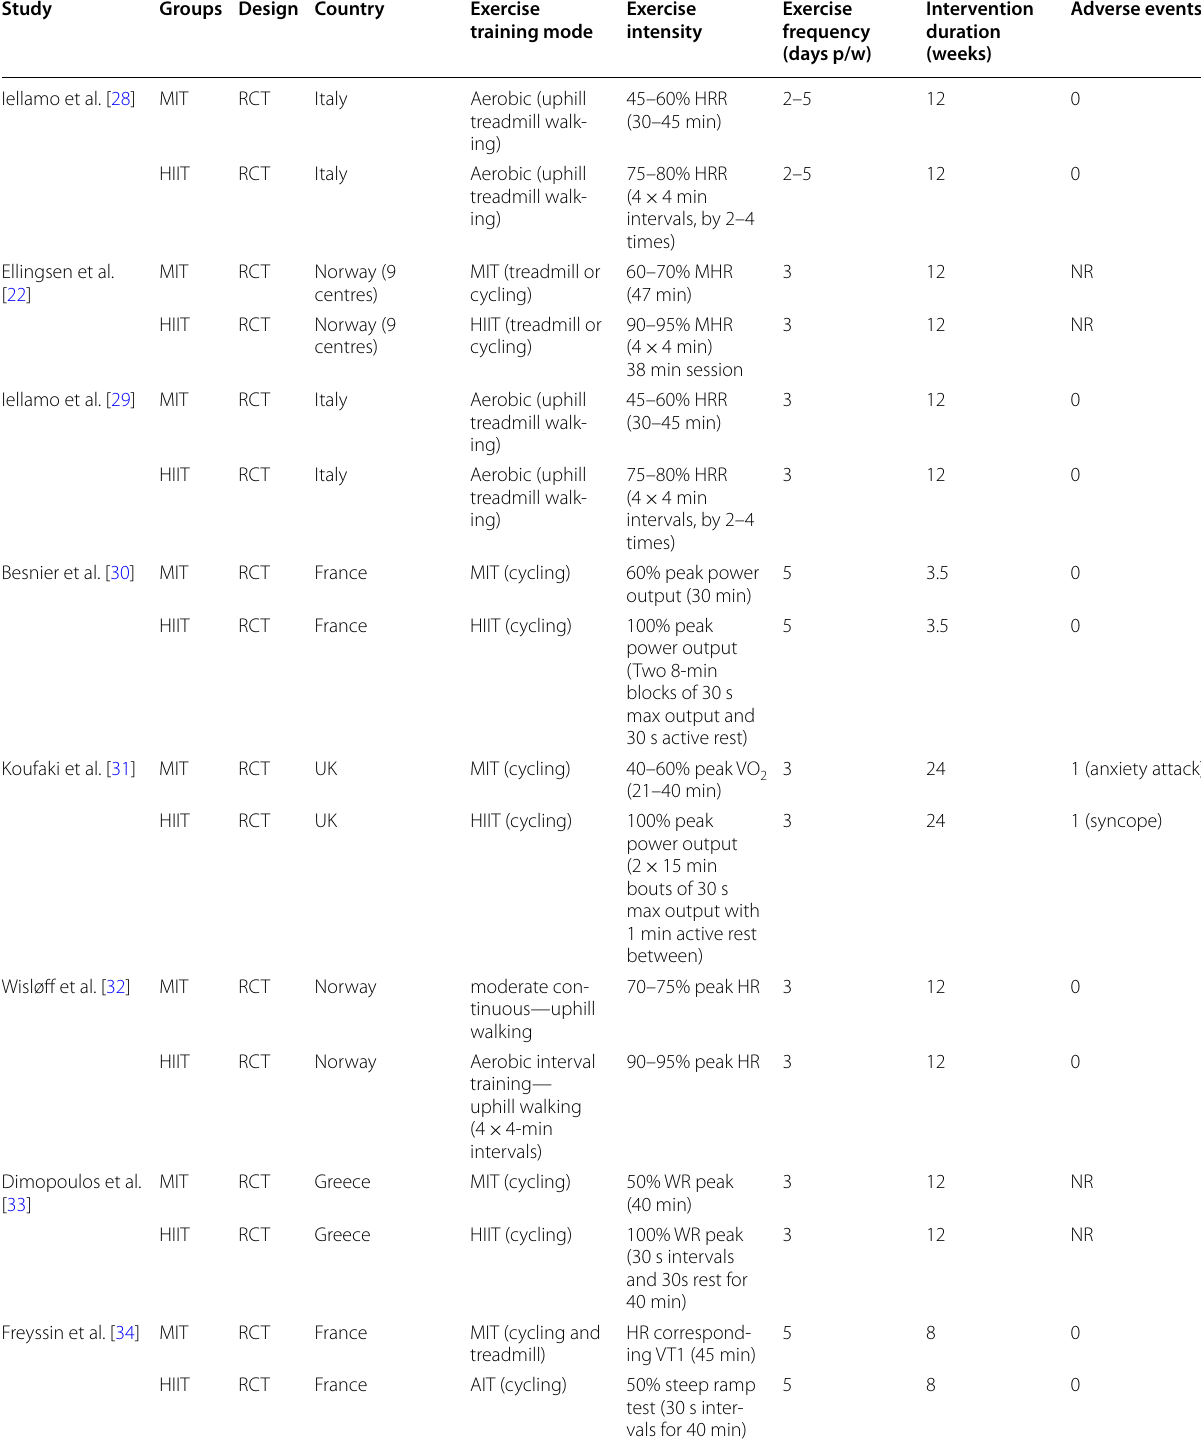
Table 2 MIT versus HIIT training